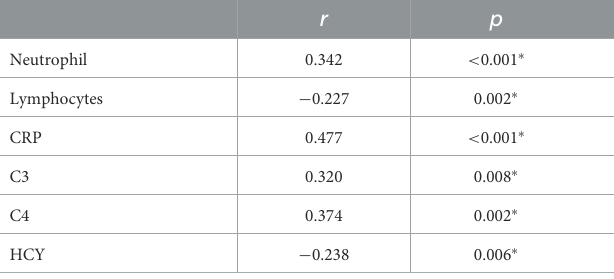
TABLE 10 Correlation between FARP and other laboratory